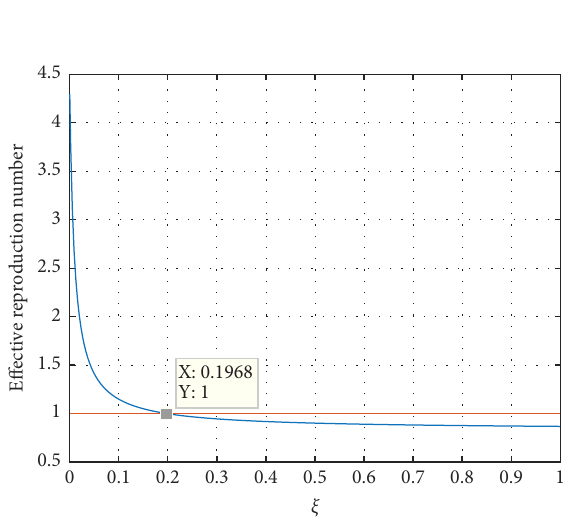
Figure 4: ξ verse R